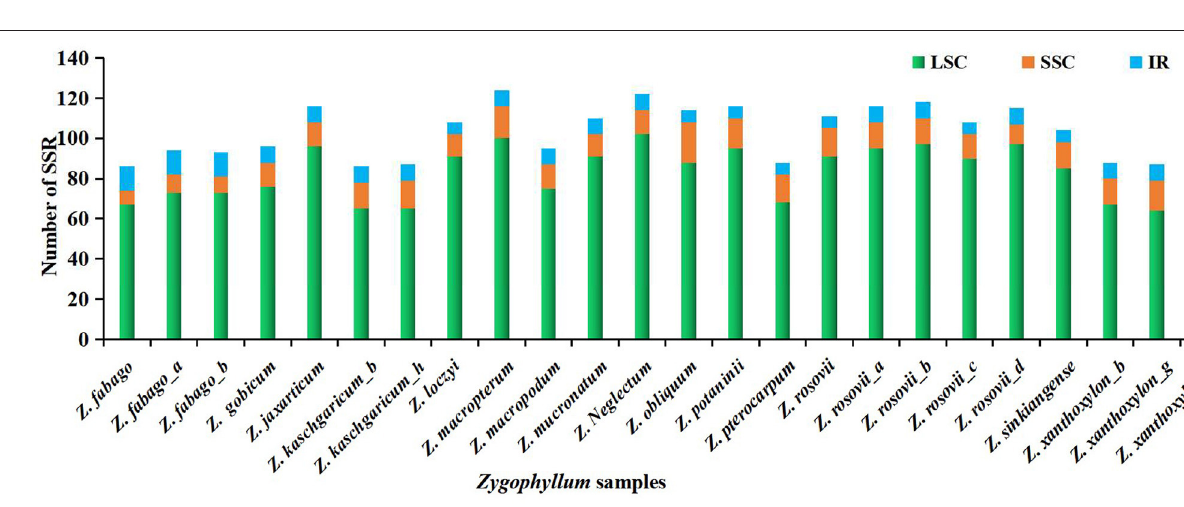
FIGURE 6 | Number and distribution of SSRs in 24 complete cp genomes of Zygophyllum